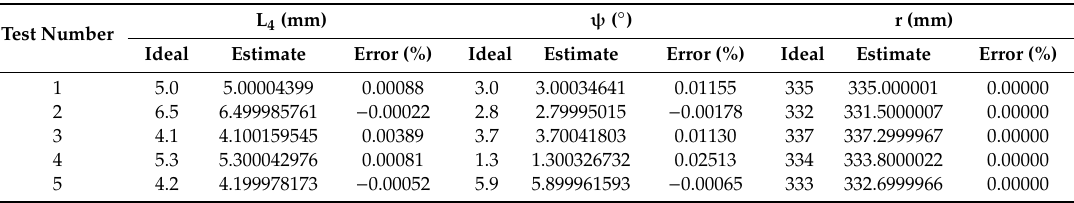
Table 1. Calibration results of the three parameters obtained from Step I.